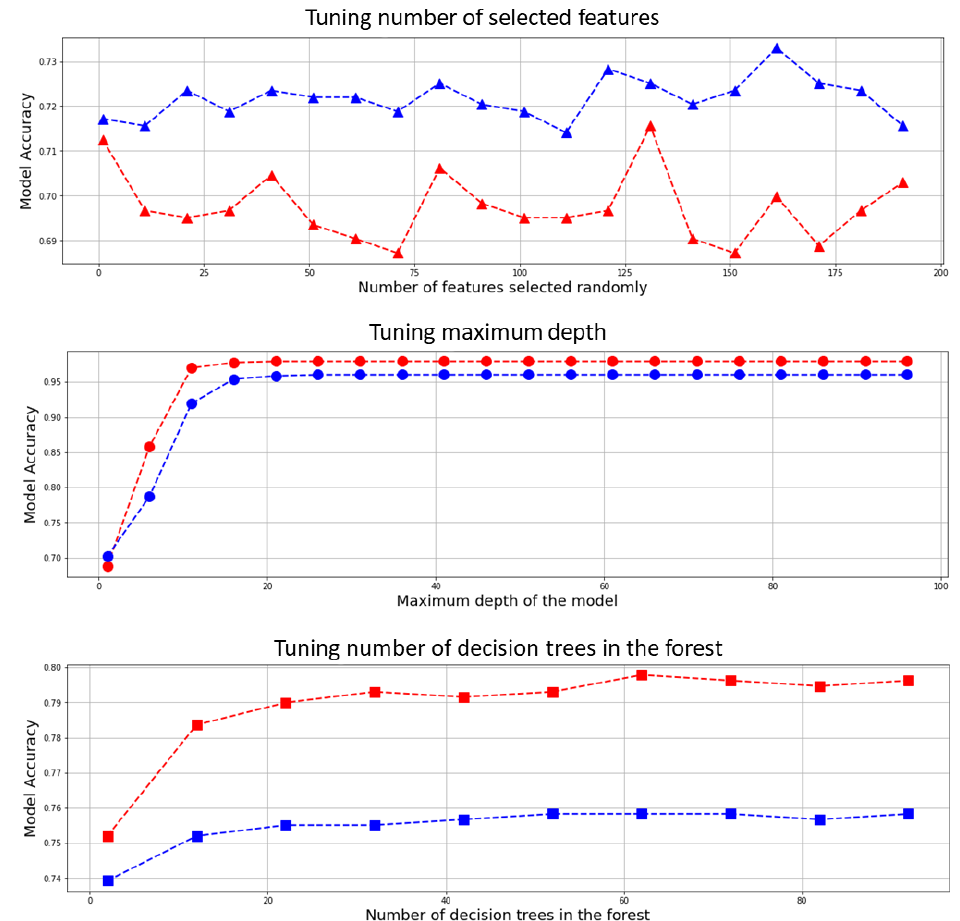
Figure 6. Hyperparameter tuning for the random forest, blue curves are representing deep radiomics and red curves show conventional radiomics fed to the model for the tuning using leave-one-out cross validation.